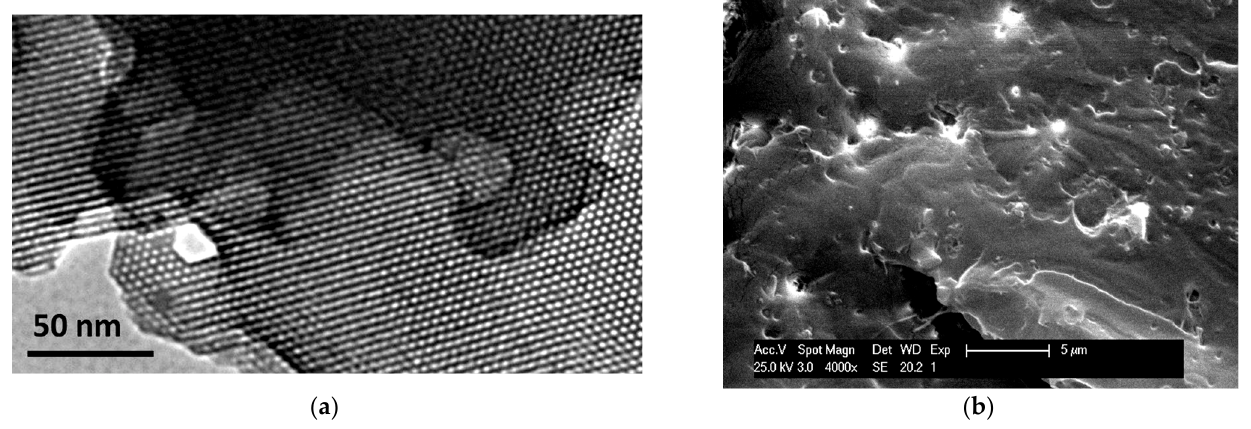
Figure 1. ( a ) TEM micrographs of MCM-41. ( b ) SEM fracture picture for the PLAM5 composite.